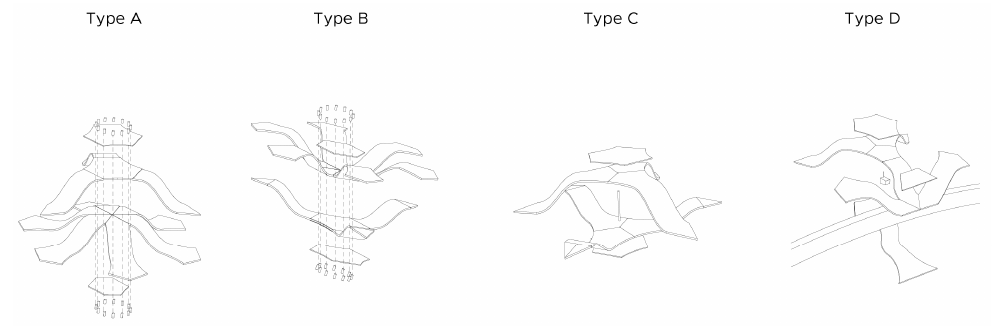
Figure 3. Isometric view of the four main details composed of single curved panels of the modular system. In combination, the single parts create re-usable structural